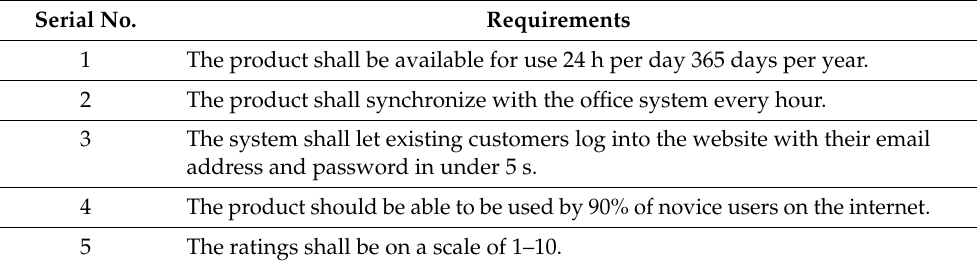
Table 1. Requirements examples from the PROMISE NFR dataset [54]. Serial